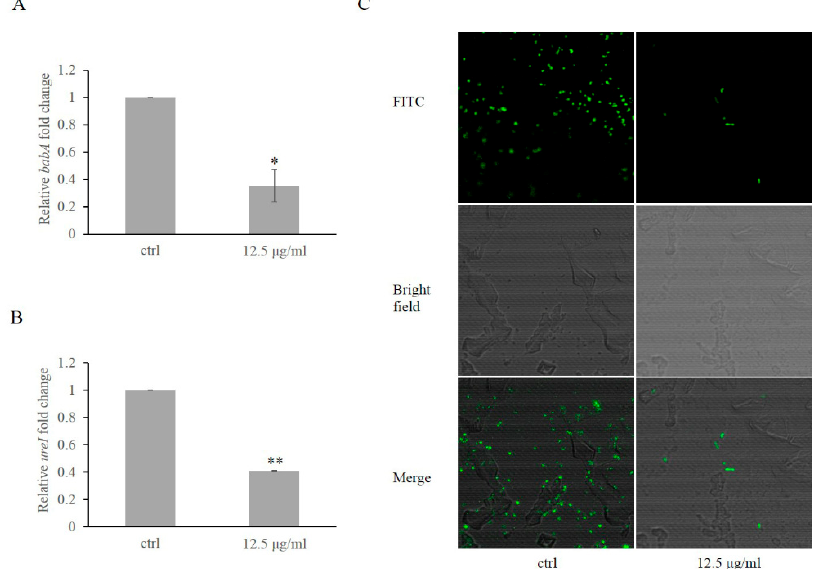
Figure 5. The transcription of babA ( A ) and ureI ( B ) in H. pylori with/without daphnetin exposure. The expression of the study genes without daphnetin exposure was normalized as 1. Inhibitory effect of daphnetin on adhesion of H. pylori to GES-1 cells ( C ). The level of adherence of H. pylori was detected by confocal (magnification: 600). All the data were presented as mean and standard deviations (SD). * p < 0.05, ** p < 0.01 vs. control.